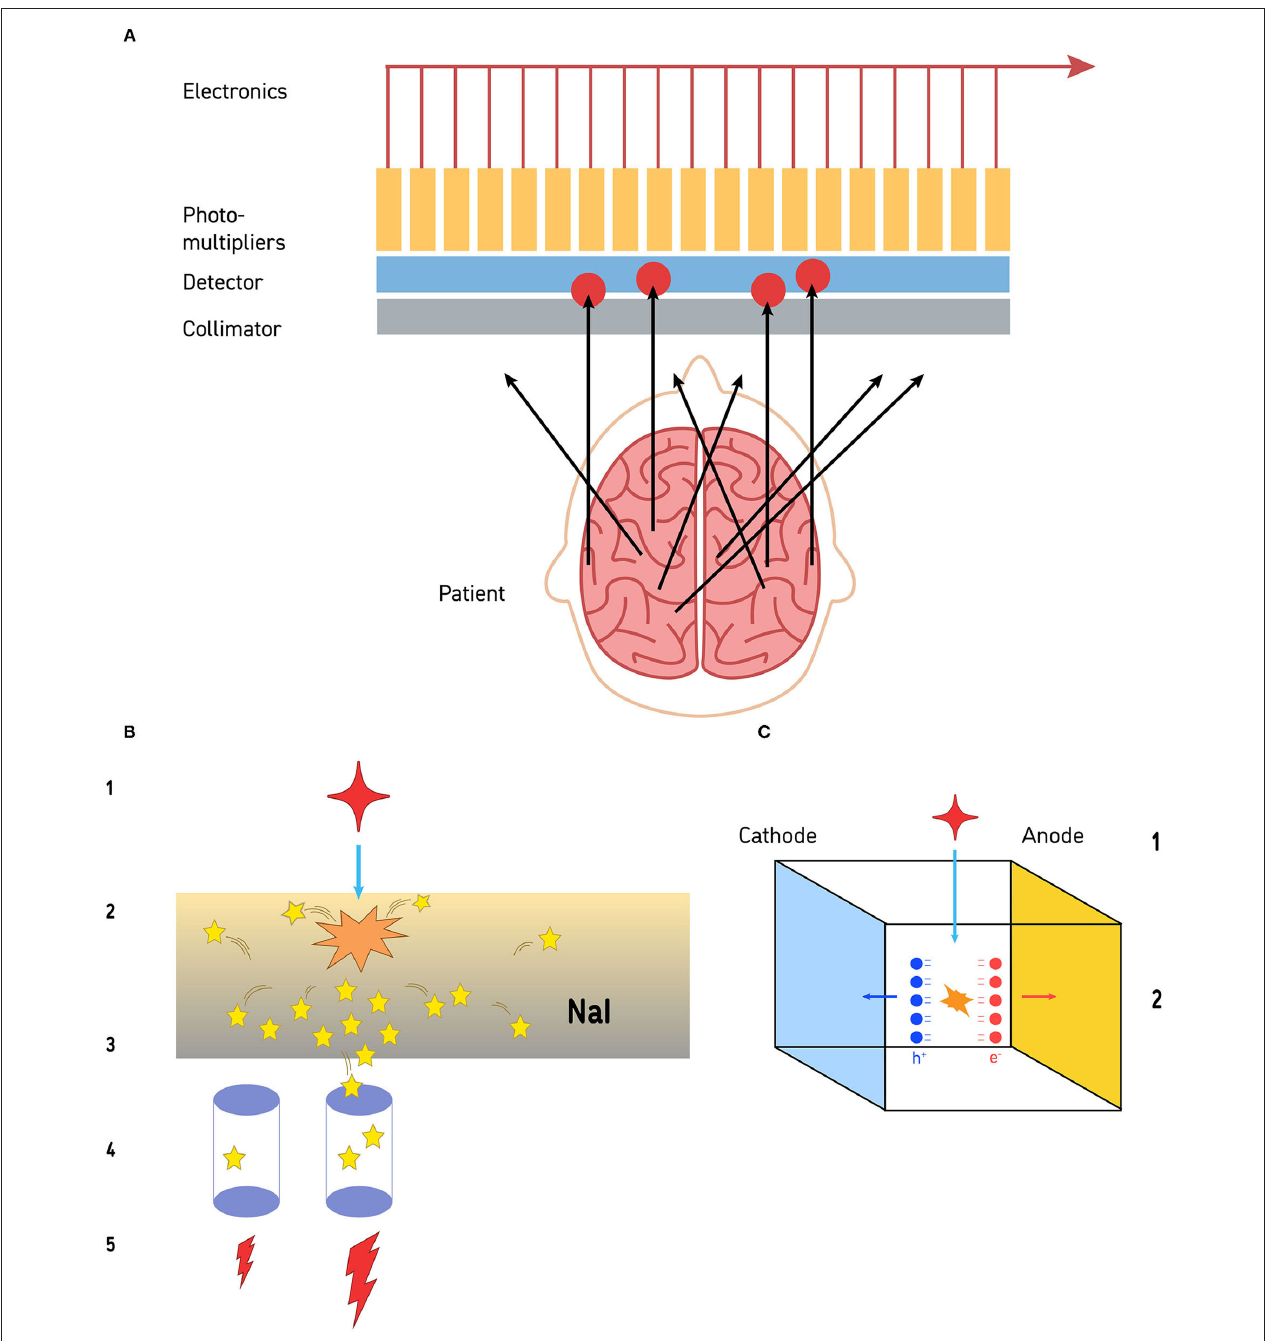
FIGURE 1 | (A) The collimation process is illustrated. Gamma photons released by the radiopharmaceutical travel away from the site of emission in all directions. Those that impact the collimator at an angle cannot pass through. Gamma photons that reach the collimator in alignment with the channels of the collimator can pass through and reach the detector (a sodium iodide crystal in this illustration). The limit to resolution is the size of the photomultipliers , distance from the structure of interest, and the resolution of the collimator. (B) Detection of gamma photons by sodium iodide crystal detectors is a multi-step process. The gamma photon (red star − 1) strikes the sodium iodide crystal (orange starburst) and a burst of visible light photons (yellow stars) is released (2). The light photons radiate in all directions (3). Some of those visible light photons will impact on photodetectors (purple cylinders − 4). Photodetectors closer to the site of gamma photon impact will receive more visible light photons, while those further away from the site will receive less (4). Those photodetectors that receive more visible light photons will release a greater electrical current, while the detectors further away will release a small electrical current (5). This is the basis of the Anger circuitry for geometric localization. (C) Cadmium-zinc-telluride (CZT) detectors are solid-state and directly convert gamma photons into electrons at room temperature. When a gamma photon (1) strikes a CZT detector (2), pairs of electrons and holes are generated (red and blue balls, respectively). These create an electrical potential across the detector which is proportional to the energy of the impinging radiation. The resolution is limited by the size of the CZT detector—currently about 2.4mm on a side.